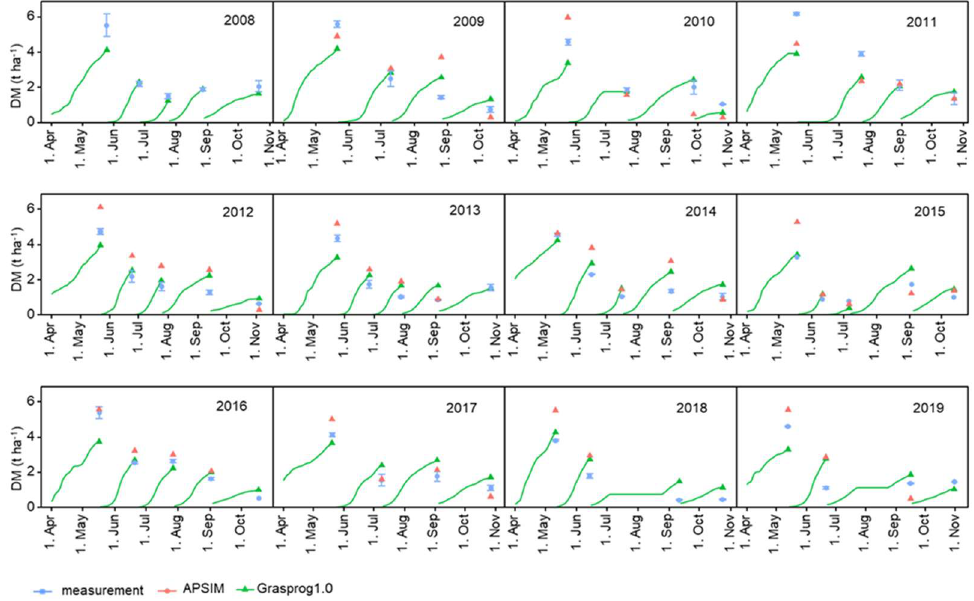
Figure 6. Measured grass dry matter (DM) for different cuts and years for Kleve, Germany. The predictions by GrasProg1.0 and APSIM are shown.